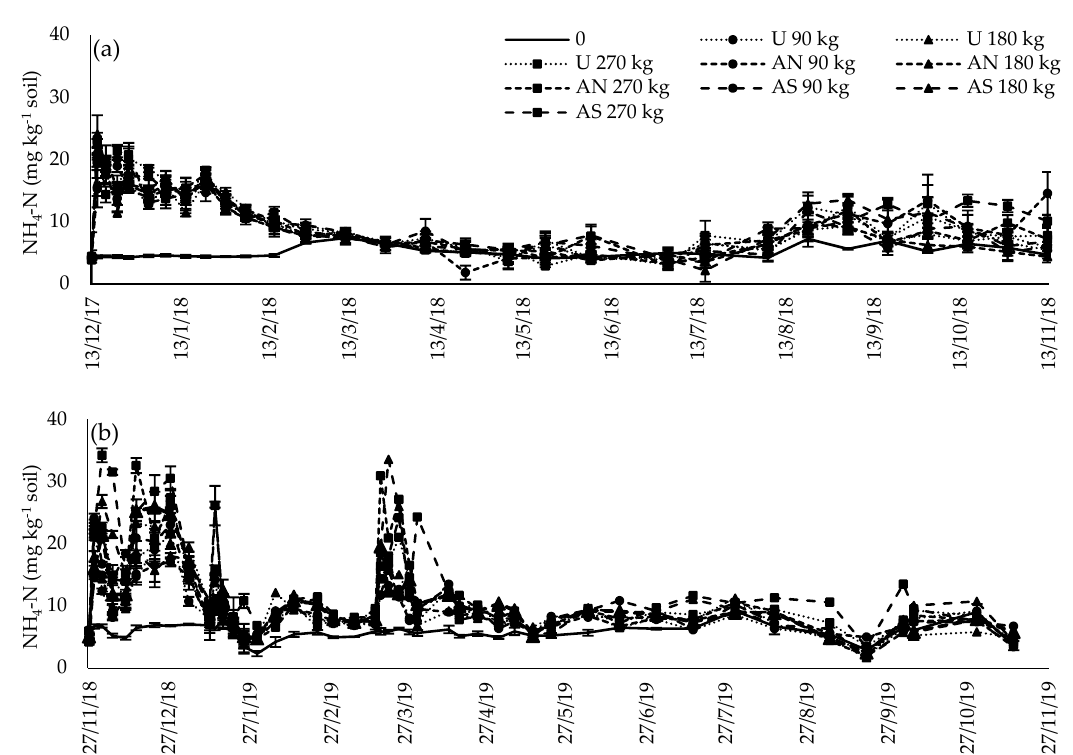
Figure 6. Descriptive averages of NH 4 –N content of soil (mg NH 4 –N kg − 1 dry soil). Experiment 1 ( a ) and 2 ( b ).